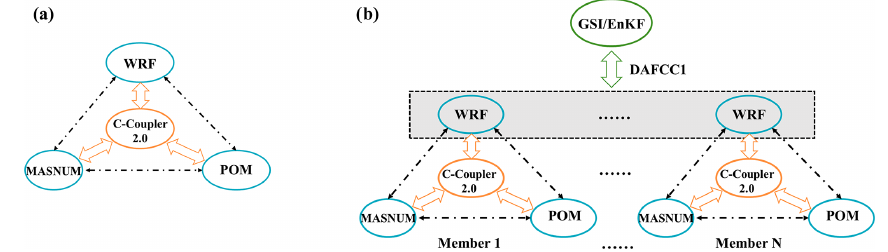
Figure 10. Architecture of FIO-AOW (a) and the corresponding example ensemble DA system (b) . The gray shadow in the dashed rectangle in (b) indicates that atmospheric analyses are computed by GSI/EnKF that has been coupled with the ensemble of WRF based on DAFCC1.